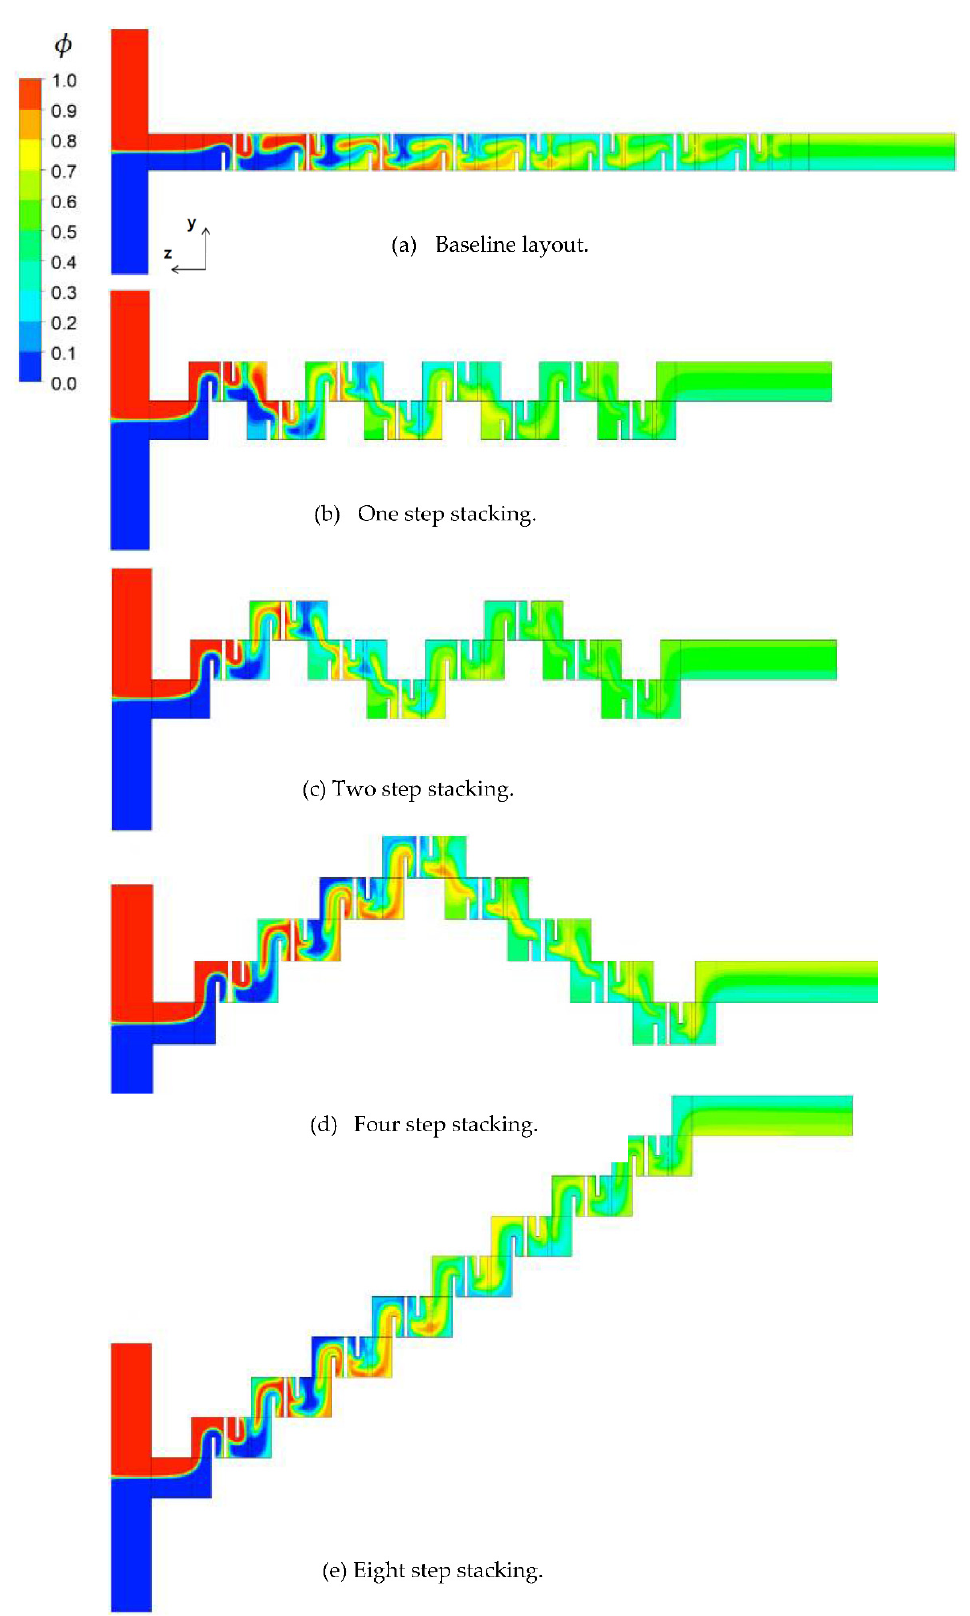
Figure 7. Concentration distribution for Re = 1 at the plane of half width z = 60 μ m.